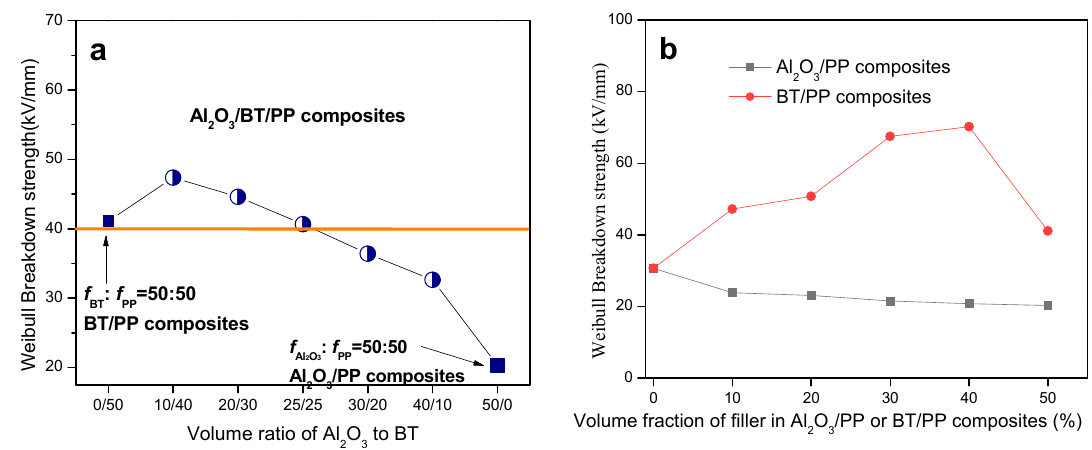
Figure 7. Weibull breakdown strength of the composites as a function of filler content: ( a ) Al 2 O 3 /BT/PP composites; ( b ) Al 2 O 3 /PP and BT/PP composites.